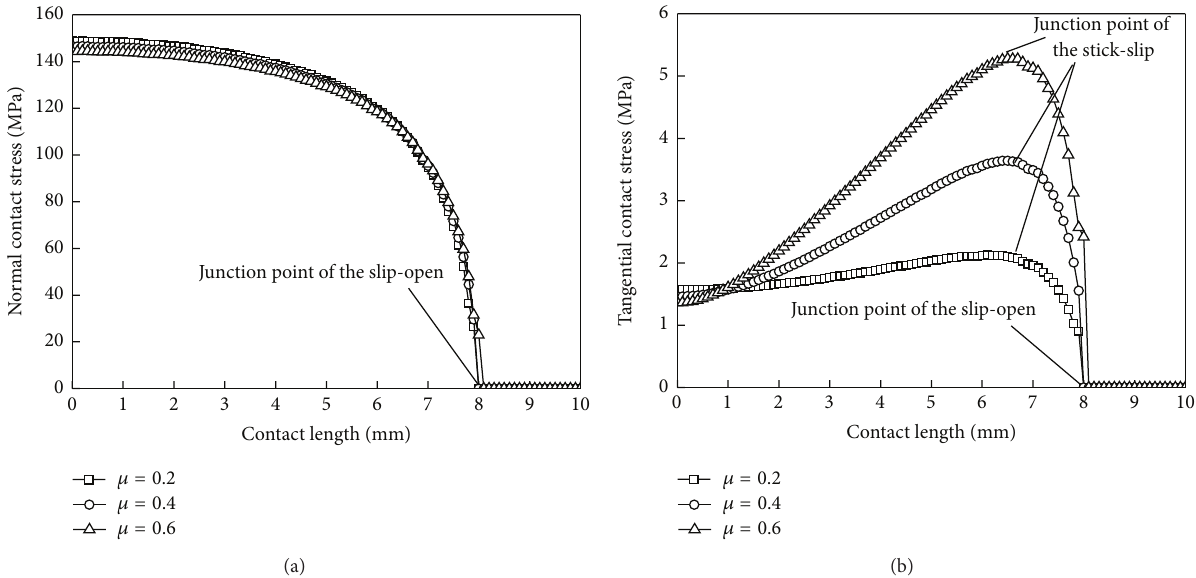
Figure 13: Contact stress distribution curves under different friction coefficients. (a) Normal contact stress and (b) tangential contact stress.